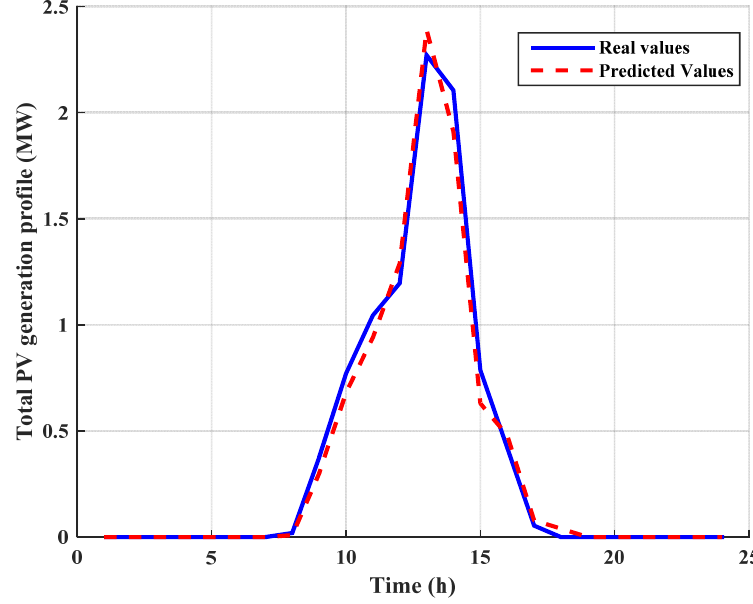
Figure 7. The real and predicted values for Photovoltaic (PV), generation profile over a day horizon.